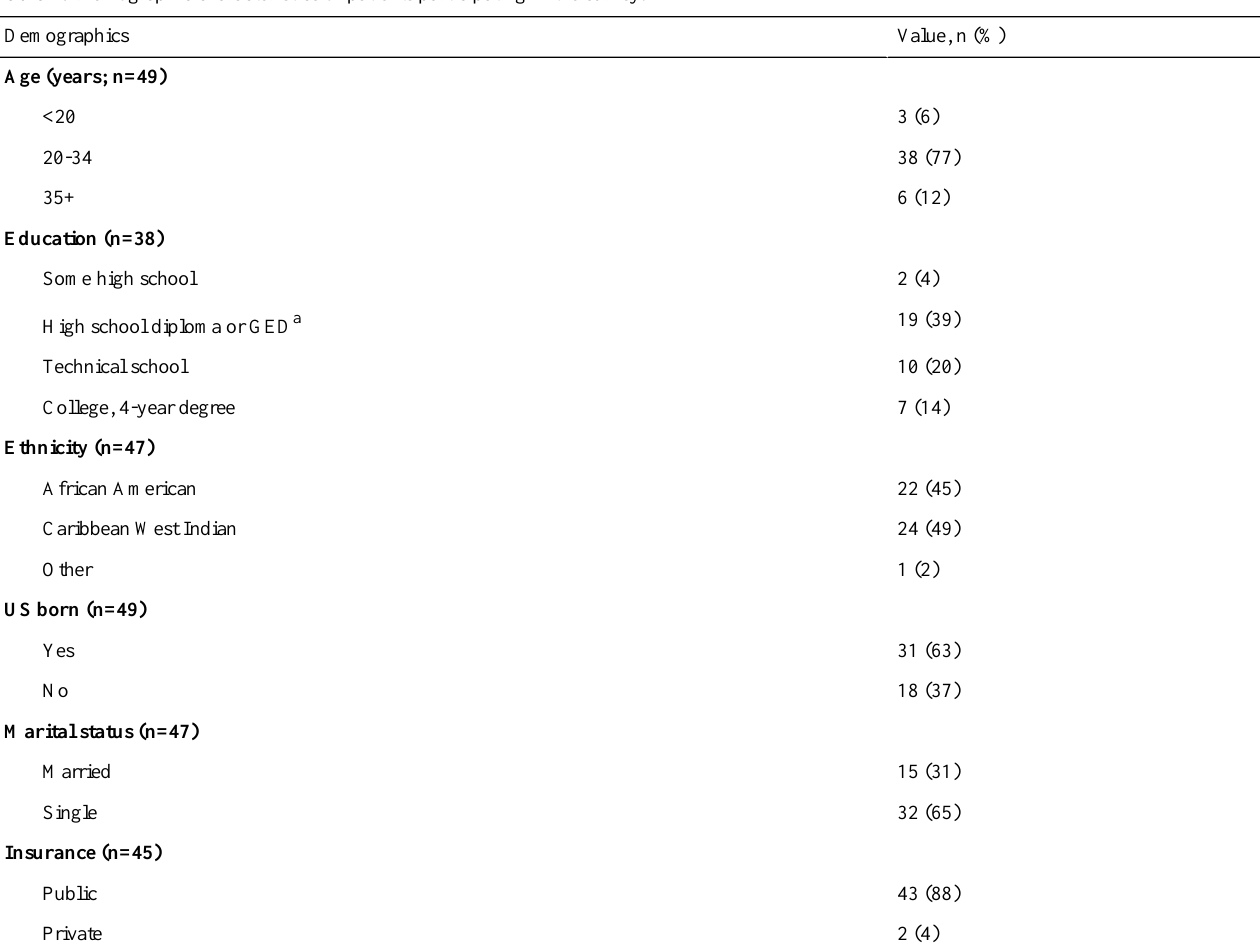
Table 4. Demographic characteristics of patients participating in the